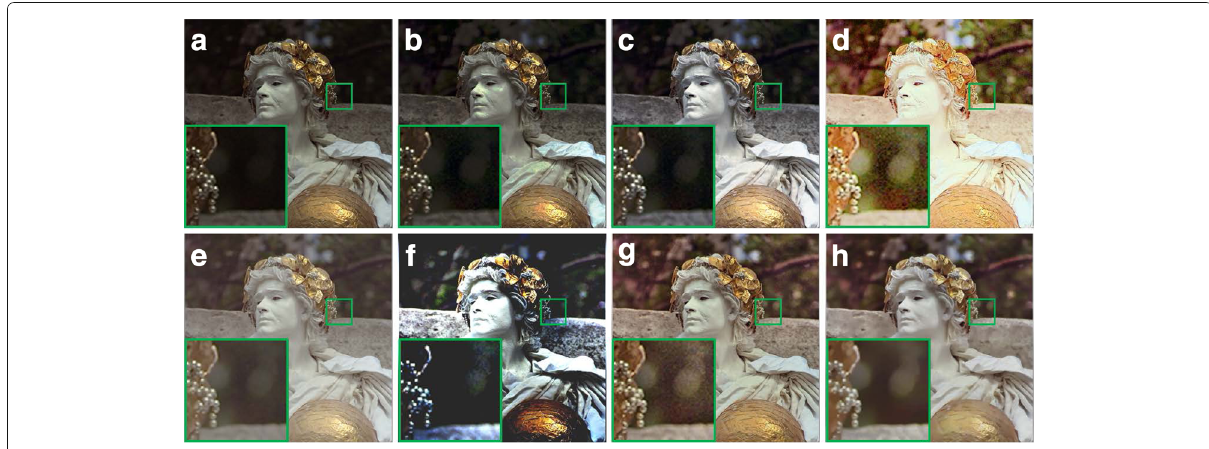
Fig. 9 Result of the proposed and conventional methods: a input image, b Chen’s method [2], c Kim’s method [3], d Jiang’s method [8], e Ravi’s method [23], f Jobson’s method [14], g Fu’s method [16], and h the proposed method ( λ 1 = 300, λ 2 = 0.1, λ 3 = 0.9, and ω = 10)